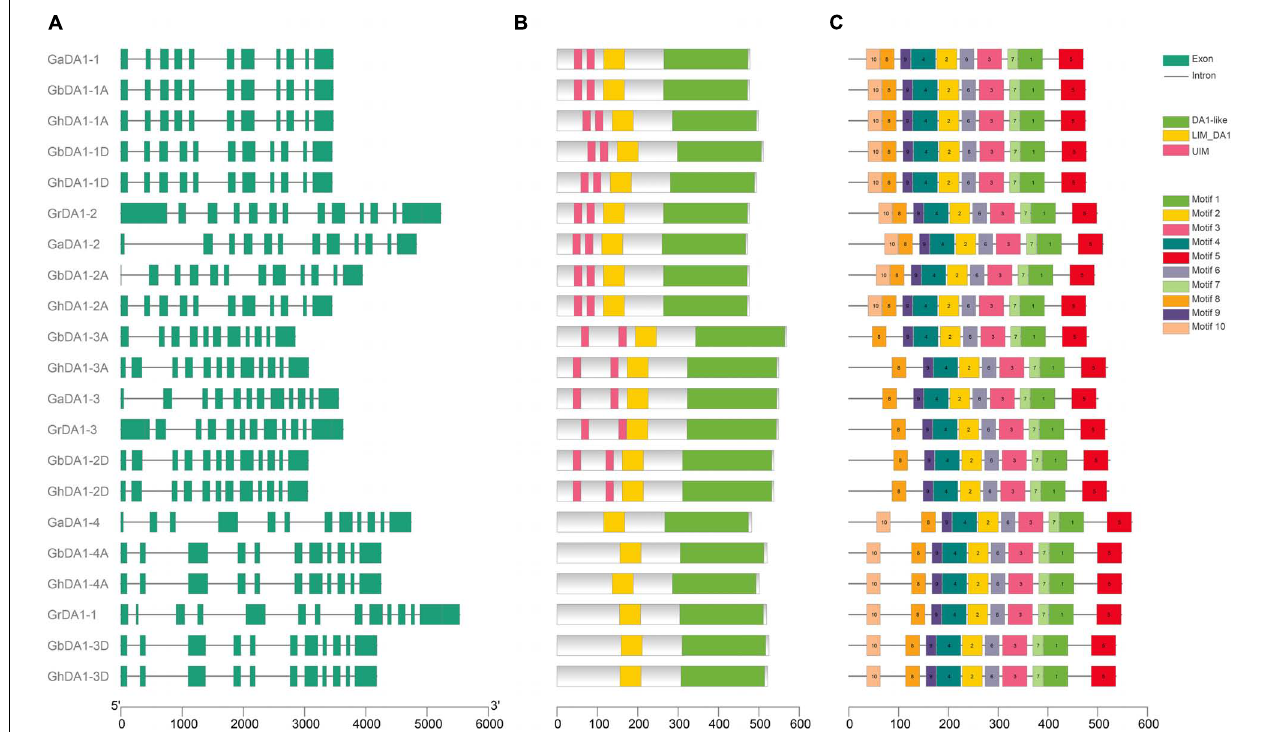
FIGURE 2 | Gene structure and protein domain analyses of DA1-like genes in Gossypium . (A) The exon-intron structure of DA1-like genes in G. raimondii, G . arboreum, G. hirsutum, and G. barbadense . (B) DA1-like protein domain prediction. (C) The motifs of DA1-like genes in G. raimondii, G . arboreum, G. hirsutum, and G. barbadense ,